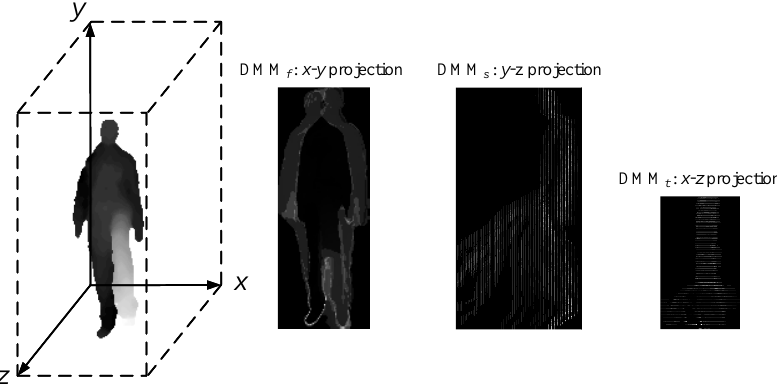
Figure 4. DMM V generated from a “forward kick” sequence.